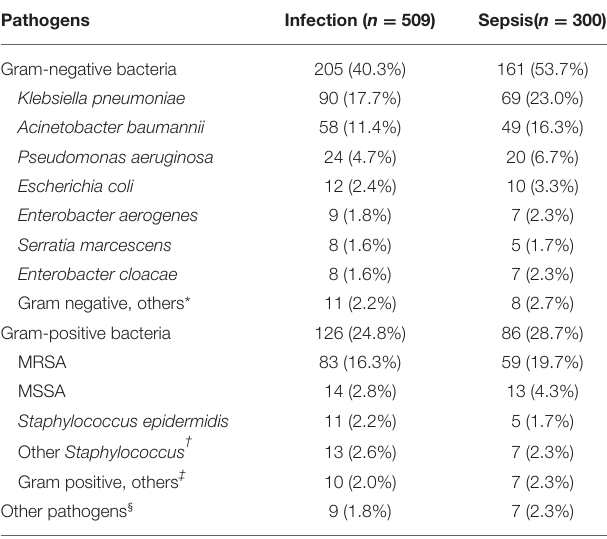
TABLE 3 | Pathogens isolated from patients with infection and